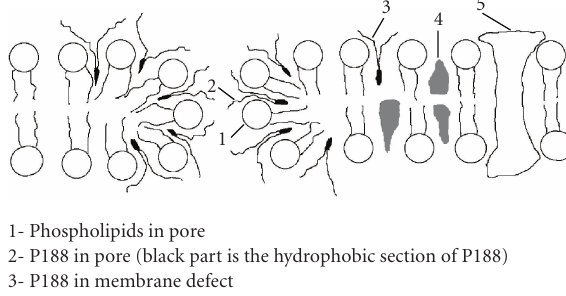
Figure 9: Scheme on the mechanism of P188 interaction in biological membrane (explanation is given in the